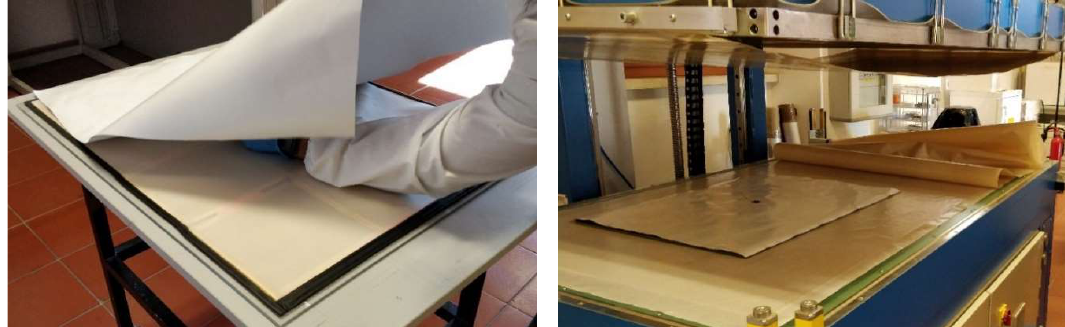
Figure 4. On the left , backsheet insertion on the panel; on the right , panel ready to be laminated. Figure 4. On the ( left ), backsheet insertion on the panel; on the ( right ), panel ready to be laminated.